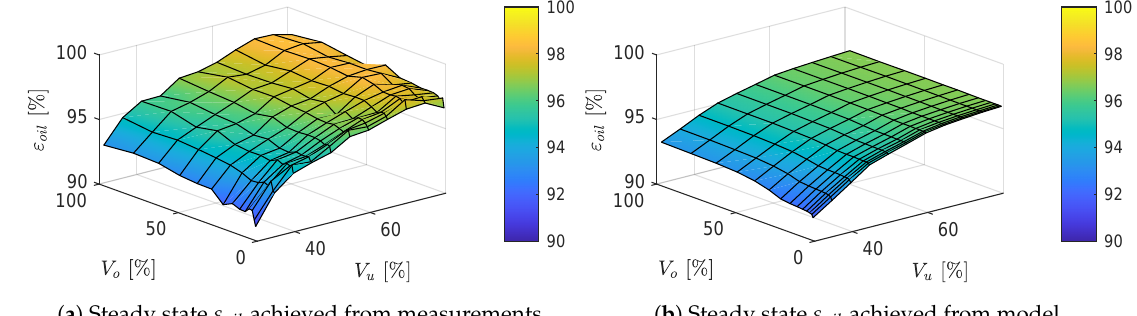
Figure 24. Steady state ε oil as function of valve